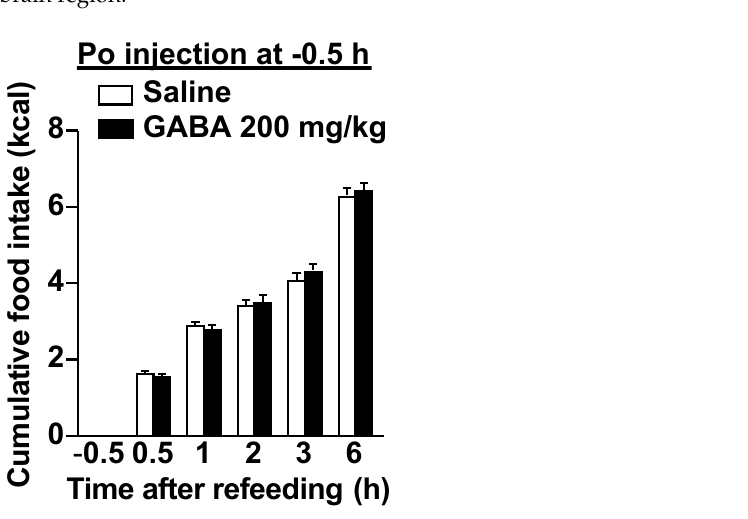
Figure 4. A single po administration of GABA does not alter ERK1/2 phosphorylation in the nodose ganglia (NGs), nucleus tractus solitarius (NTS), or area postrema (AP). A–D : Left NG ( A , B ) and medial NTS and AP in the medulla ( C , D ) sections immunostained for pERK1/2 30 min after po administration of 200 mg/kg GABA or saline to overnight-fasted mice. ( E , F ): Extended pictures of red squares in ( C ) to ( D ), respectively. Yellow arrowheads indicate pERK1/2-positive neurons. Scale bar, 100 µm. ( G – I ): The incidence of pERK1/2-positive neurons in the left and right NG neurons ( G ) and the number of them in the bilateral NTS neurons ( H ). The fluorescence intensity of pERK1/2-immunoreactivity per unit area in AP is indicated in I. n = 4. DMV, dorsal motor nucleus of vagus nerves. po, peroral. GABA: Gamma-aminobutyric acid. Dotted line: borderline indicating brain region.